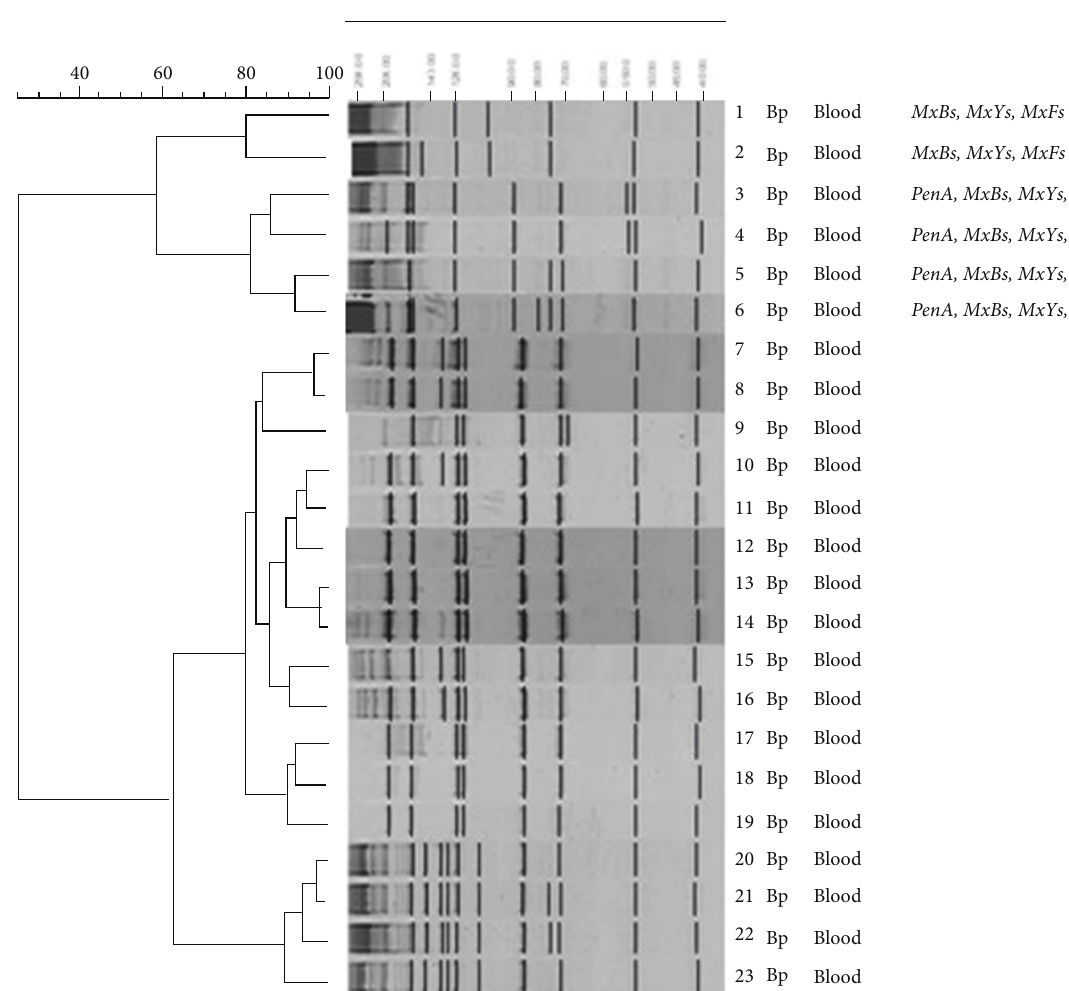
Figure 2: Random amplified polymorphic DNA (RAPD) polymorphisms of B. pseudomallei clinical isolates amplified by primer 272. The representative fingerprint patterns of two clusters RAPD were shown (i) RAPD cluster A (MDR) and (ii) RAPD cluster B